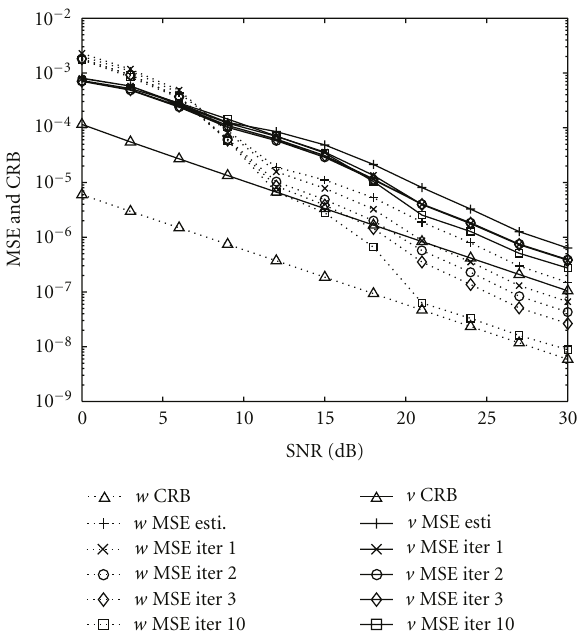
Figure 4: CFO estimation MSE versus SNR: N =